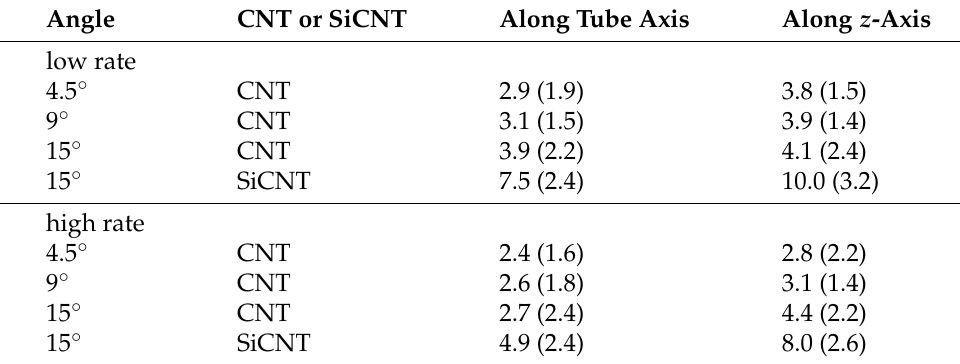
Table 1. Averaged number of lipids removed during indentation.